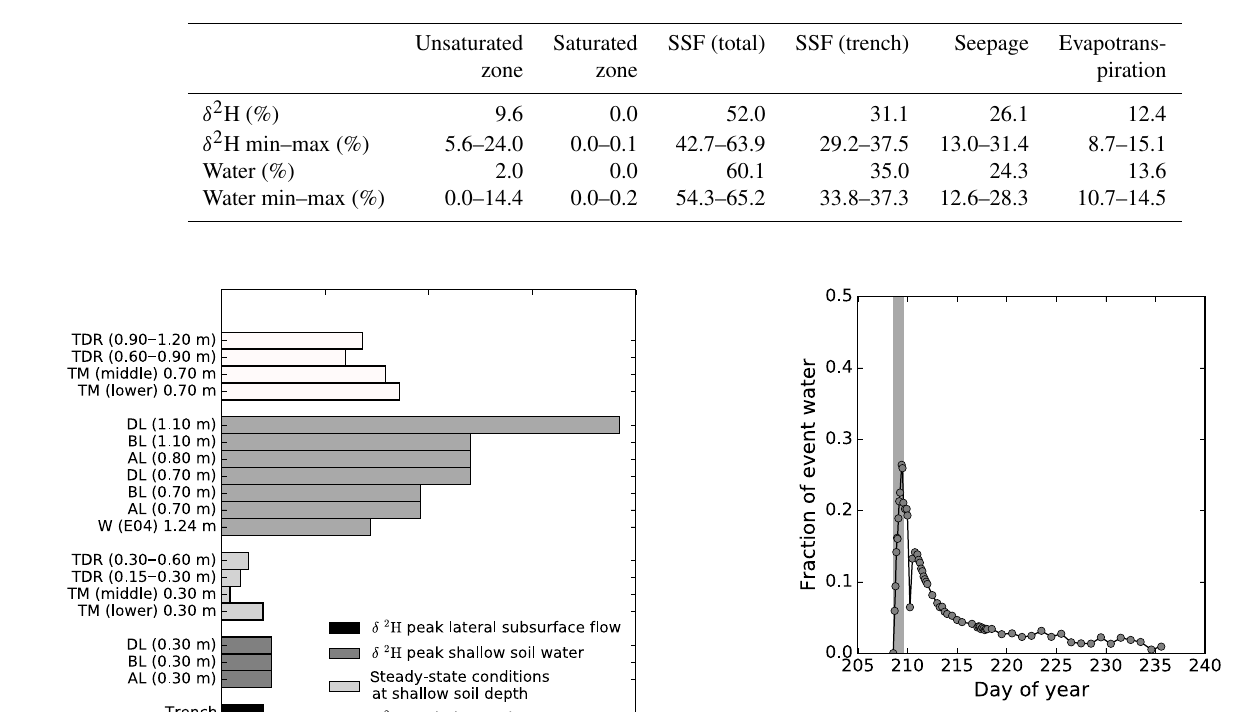
Table 5. Tracer mass ( δ 2 H) and water balance components as percentages of total input simulated by Model 2, and the minimum and maximum values for these balance components simulated by the 308 behavioral parameter sets based on lateral subsurface flow and δ 2 H. The time interval for these calculations was DOY 208–DOY 243.